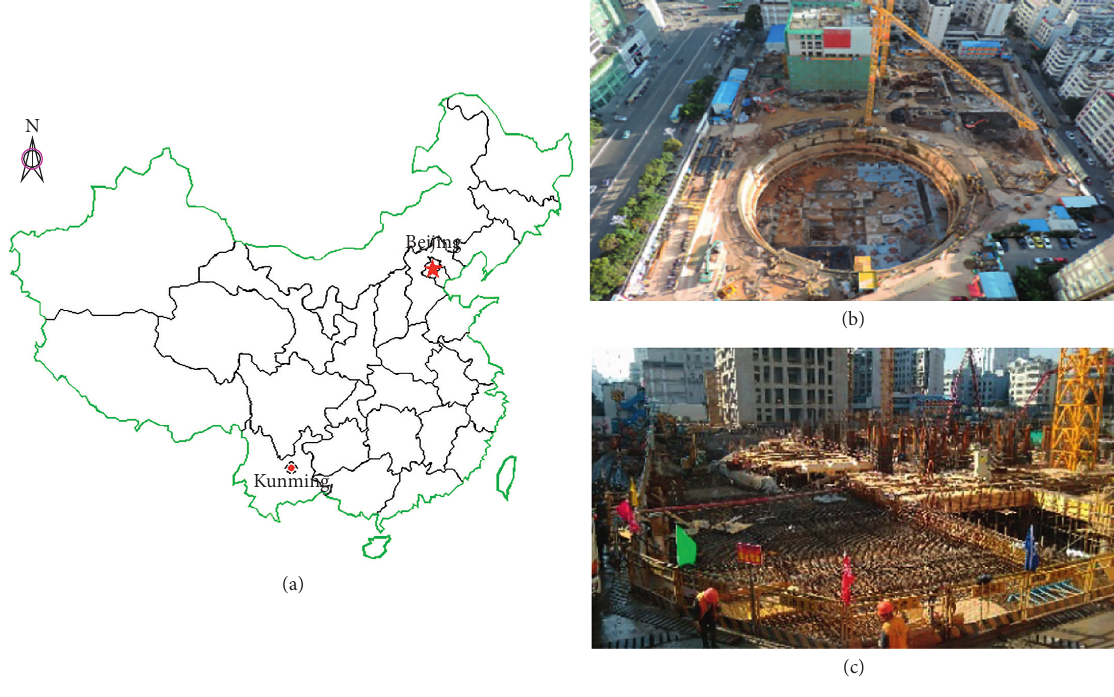
Figure 1: Site location (a). Aerial views of the project ((b),